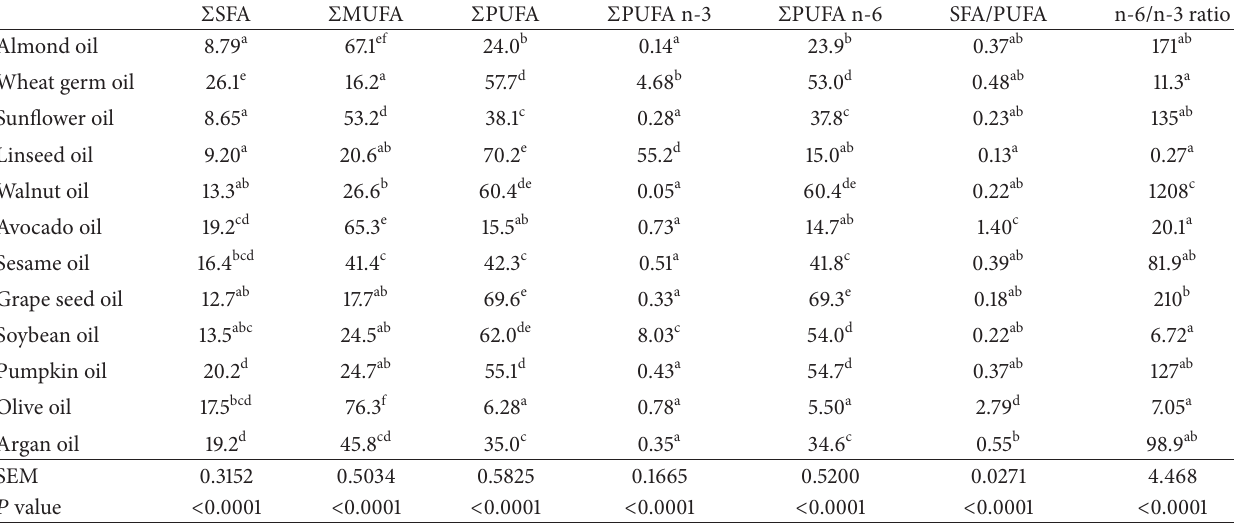
Table 4: Sum of fatty acids in edible vegetable oils ∗